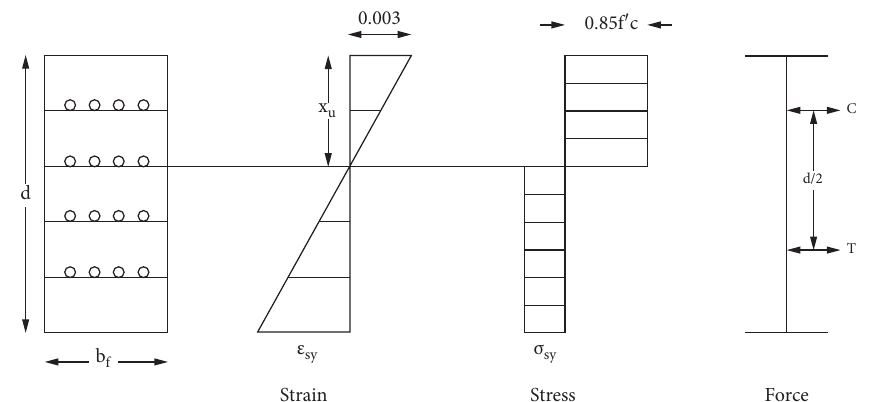
Figure 2: Stress strain block for ferrocement